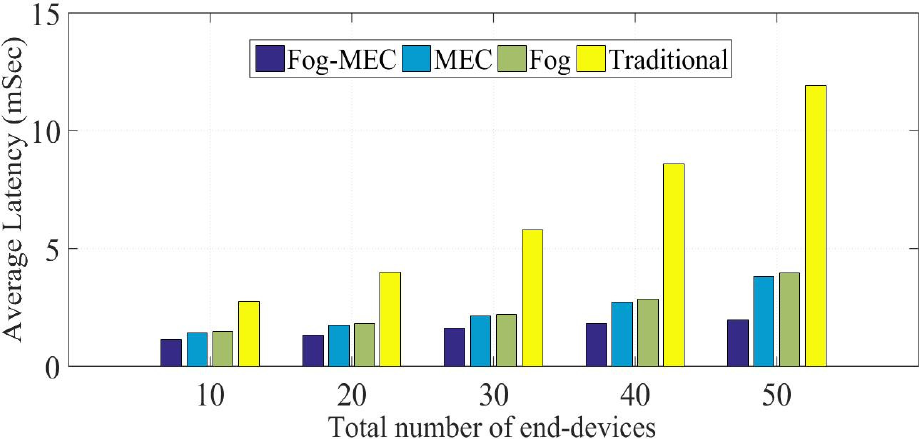
Figure 7. Average time of handling IoT tasks for the proposed fog-MEC model compared to other existing systems.